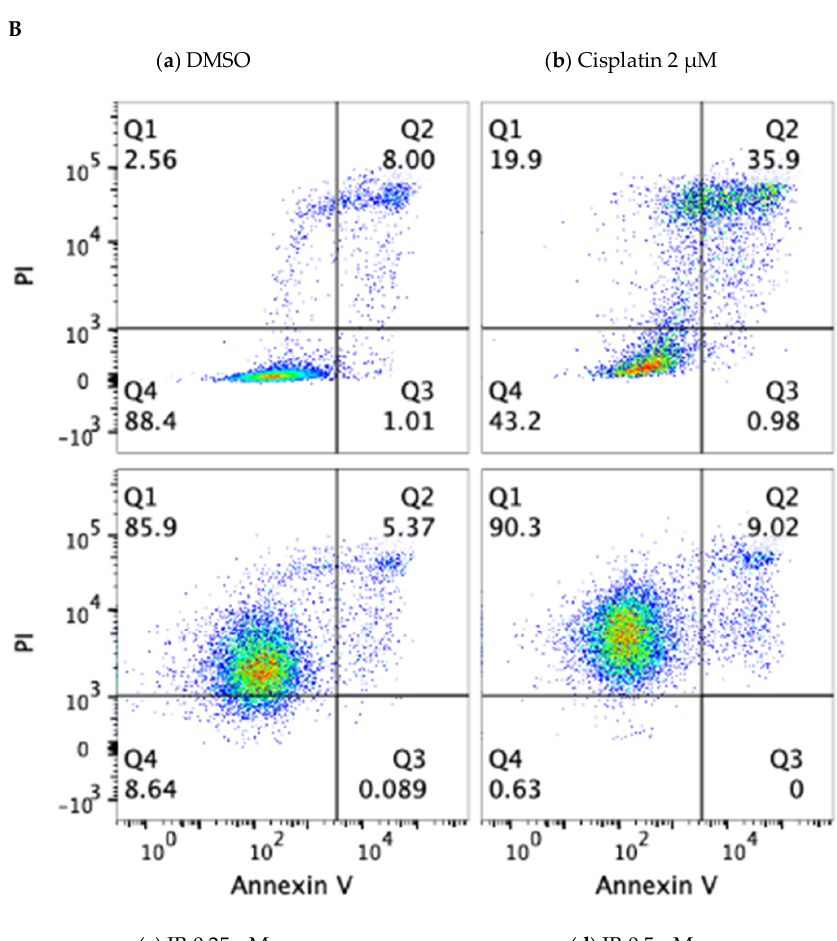
Figure 2. Imipramine blue decreases markers of invasive behavior and reactive oxygen signaling in nanomolar concentra- tions. Pak1 and ERK are markers. of invasive behavior in medulloblastoma, and catalase expression is modulated by re- nanomolar concentrations. Pak1 and ERK are markers. of invasive behavior in medulloblastoma, and active oxygen. The lack of effect of imipramine blue on PARP cleavage suggests that imipramine blue causes necrosis catalase expression is modulated by reactive oxygen. The lack of effect of imipramine blue on PARP rather than apoptosis. A( a ) Daoy cells were cultured in EMEM medium containing 10% serum for 24 h, then exposed to imipramine blue (IB) 0.25µM or vehicle for 48 h. Cell lysates were harvested for Western blot (original blots can be found cleavage suggests that imipramine blue causes necrosis rather than apoptosis. ( Aa ) Daoy cells at Figure S1). A( b ) Densitometric presentation of Western blot of three different experiments and normalized by GAPDH.